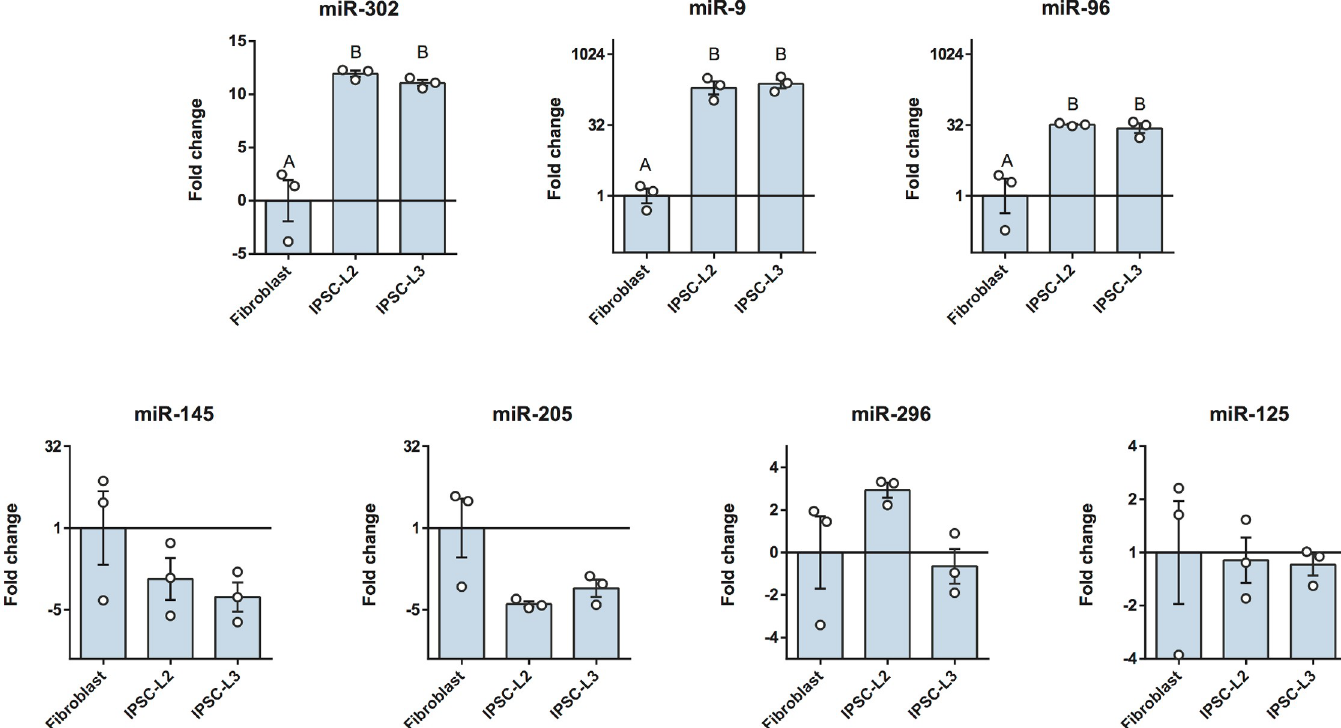
Fig 4. RT-qPCR analysis of 7 microRNAs in the L2 and L3 iPSCs lines and the original fibroblasts. Results are presented as means ± SEM (n = 3). Data were relativized to fibroblasts. Different letters indicate significant differences (p < 0.05).